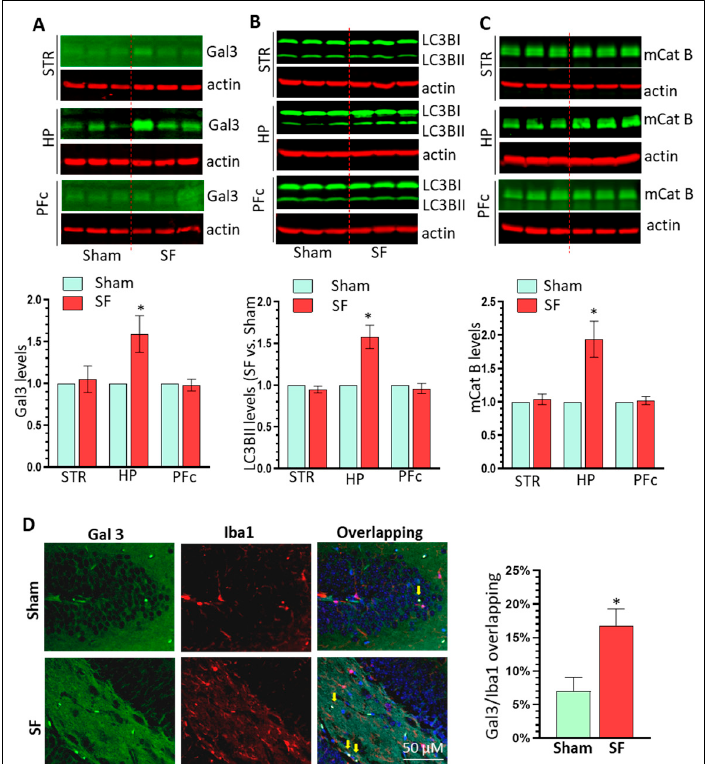
Figure 7. SF mice show increased Gal3 expression and autophagy dysregulation in the brain HP. ( A ): Three weeks of SF increased Gal3 levels in the HP but not in the striatum and PFc (n = 6, * p < 0.05); ( B ): Three weeks of SF increased LC3BII levels in the HP but not in the striatum and PFc (n = 6, * p < 0.05); ( C ): Three weeks of SF increased mCat B levels in the HP but not in the striatum and